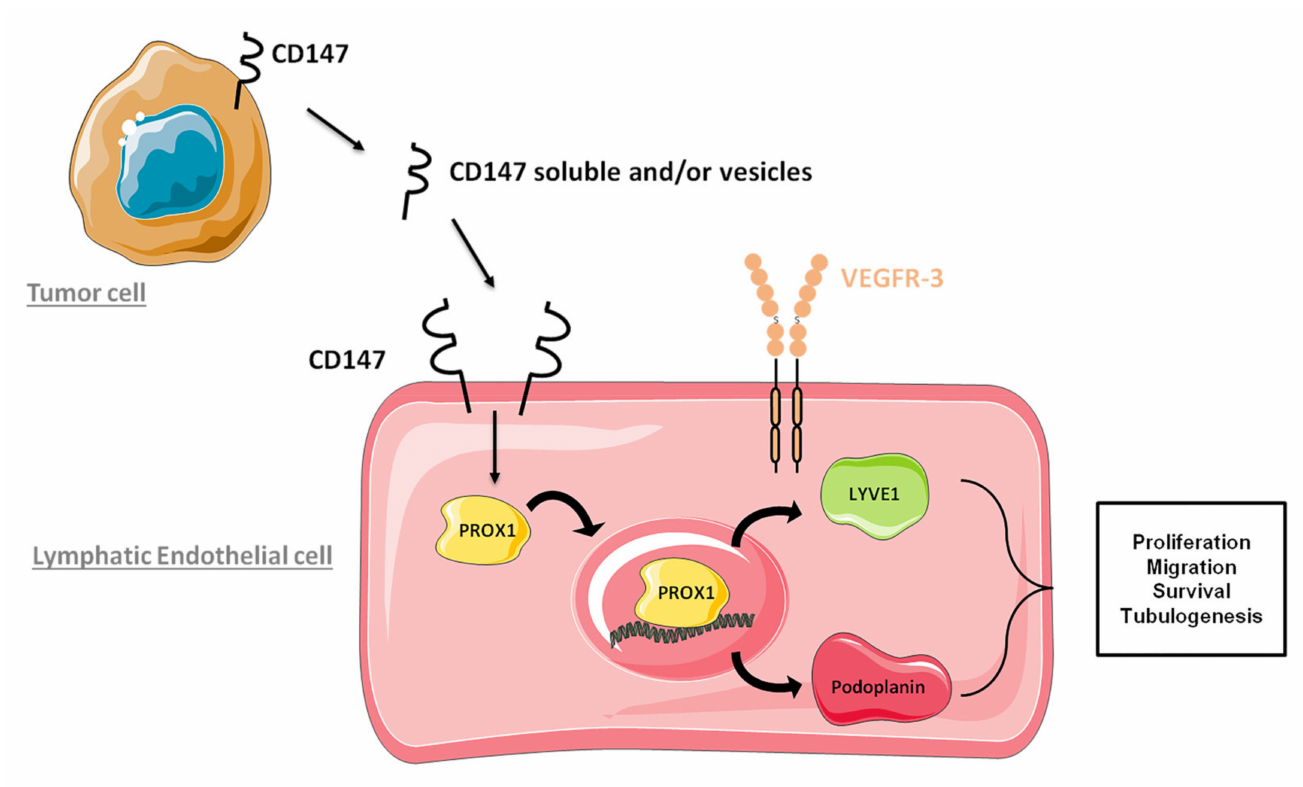
Figure 7. Schematic representation of paracrine CD147 effect on lymphangiogenesis